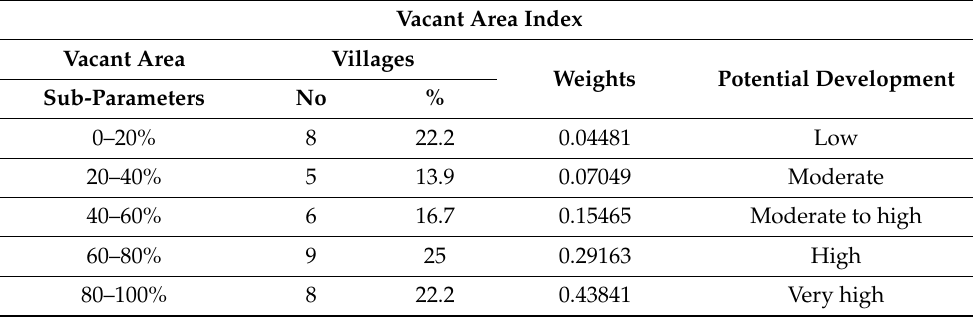
Table 10. Classification of the “Vacant area” index with their weights.